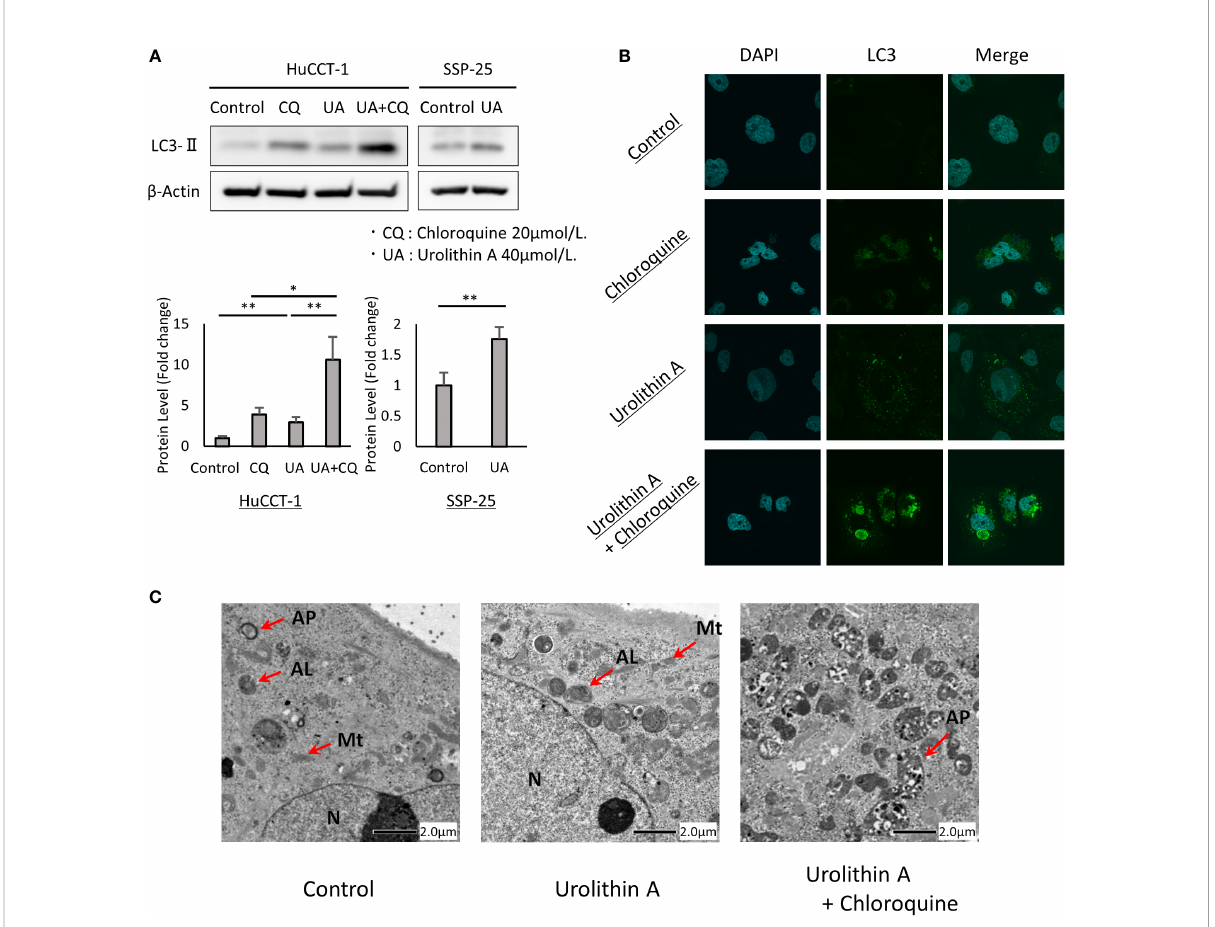
FIGURE 3 UA-mediated upregulation of autophagy in cholangiocarcinoma cells. (A) HuCCT-1 and SSP-25 cells were treated with 20 m mol/L CQ and 40 m mol/L UA for 24 h Autophagy was detected by Western blotting for LC3-II. b -actin was used as an internal loading control. LC3- II levels were normalized against b -Actin and represented the means of three independent experiments. Bars, standard deviation; *P < 0.05; **P < 0.01. (B) Immuno fl uorescence for LC3 (green) was performed after the same treatment as shown in (A) . Blue staining denotes DAPI-labeled nuclei. (C) Electron microscopy after the same treatment as shown in (A) . N, nucleus; Mt, mitochondrion; AP, autophagosome; AL,